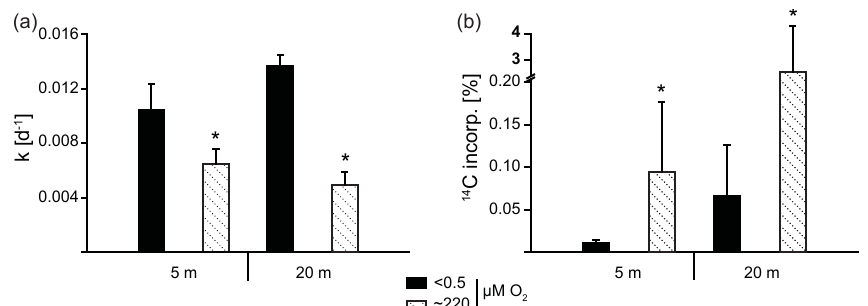
Figure 4. Methane–carbon assimilation in relation to oxygen concentration. Methane–carbon assimilation was determined from incubations amended with 14 C-CH 4 at saturated ( ∼ 220µmolL − 1 , shaded bars) or low oxygen concentrations (<0.5µmolL − 1 , black bars) of water recovered in June 2014 at 5 and 20mb.s.l. Incubations were performed in triplicates and standard deviations are indicated. (a) First-order rate constant ( k ). (b) Fraction of oxidized methane incorporated into biomass. Asterisks indicate a p value<0.05 of a two-tailed, two-sample t test assuming equal variance between the samples at low and high oxygen concentrations.